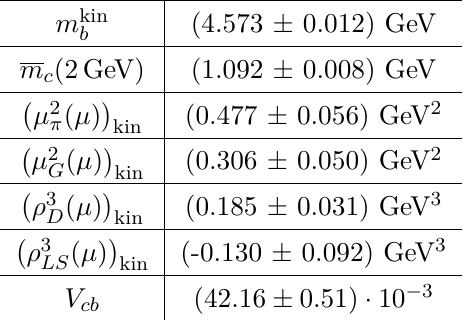
Table 1 . Numerical inputs taken from [1], where the HQE parameters are defined in the perp basis. For the charm mass, we use the MS scheme at 2 GeV. All other hadronic parameters are in the kinetic scheme at µ = 1